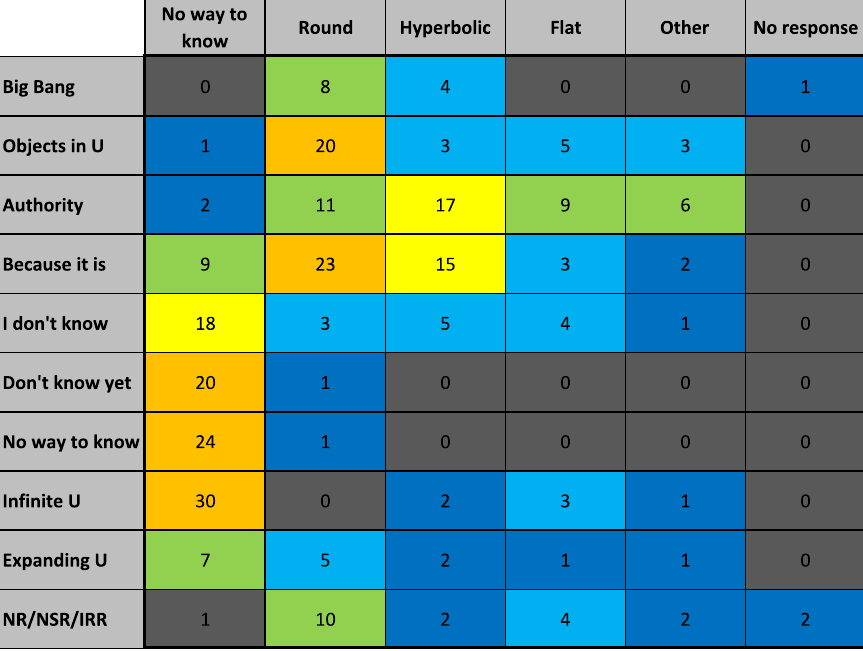
FIG. 6. Heat map highlighting the relationships between ASTRO 101 students ’ selection of the geometry or curvature of space with their responses to Why did you select the answer you chose? ( N ¼ 265 ). Each cell specifies the number of responses coded with a particular combination of curvature and